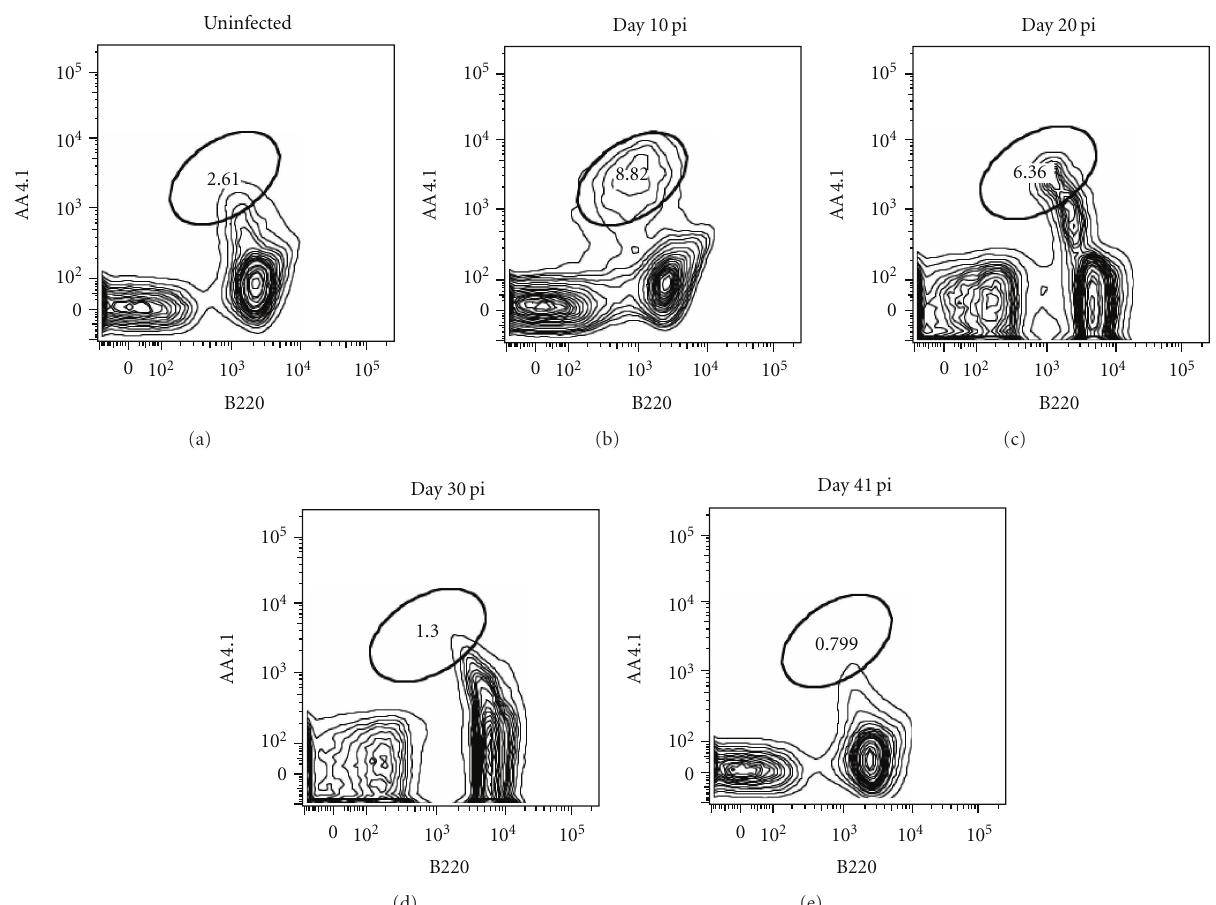
Figure 4: Extramedullary B lymphopoiesis in spleen during Pc AS infection. Spleens cells from noninfected mice and mice infected with Pc AS for 10–41 days were stained for surface markers used to define developing B cells. The total B cell precursor population, including pre-pro-B, pro-B, pre-B and immature B, was detected as 7AAD − Lin − B220 int AA4.1 hi using FACS. Data are representative of two separate